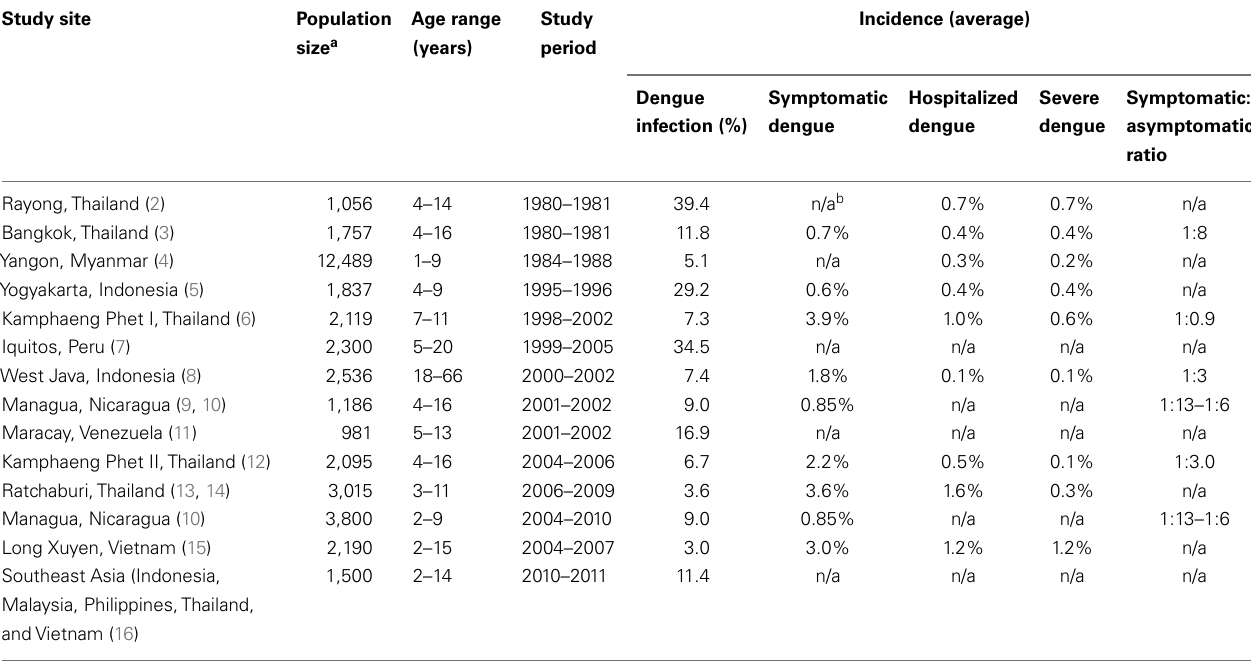
Table 1 | Summary of prospective cohort studies of DENV transmission and